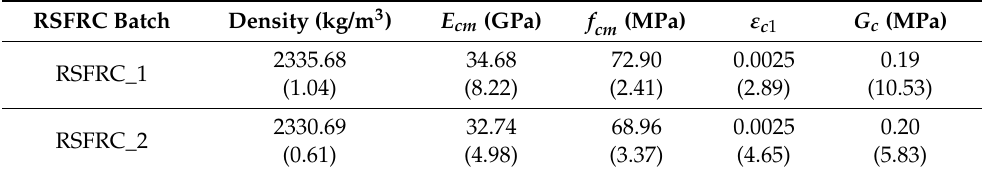
Table 3. Average results (and coefficients of variation (CoV) of compression tests.